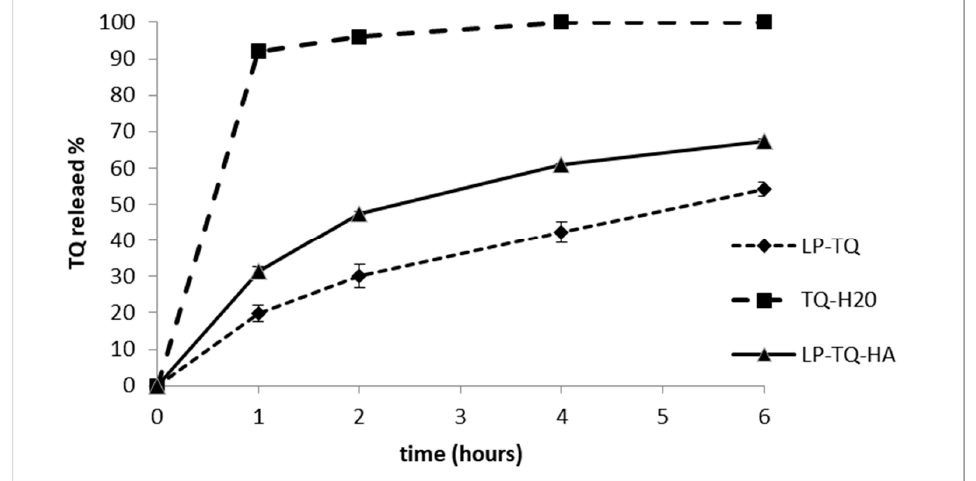
Figure 2. In vitro release profile of TQ from the LP ‐ TQ, LP ‐ TQ ‐ HA, and TQ aqueous saturated so ‐ lution in phosphate buffered saline (PBS) medium at pH 7.4, at 37 °C. Each value is the mean ± SD solution in phosphate buffered saline (PBS) medium at pH 7.4, at 37 ◦ C. Each value is the mean ± SD of three separate samples. of three separate